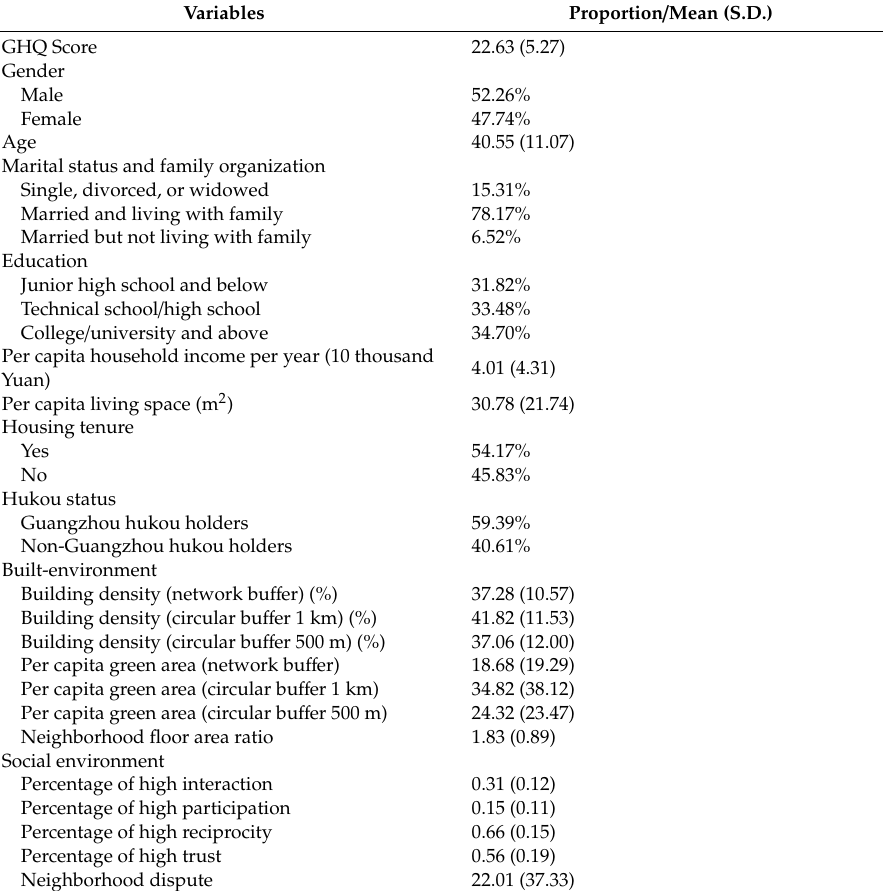
Table 1. Summary statistics of residents’ socio-demographics and neighborhood